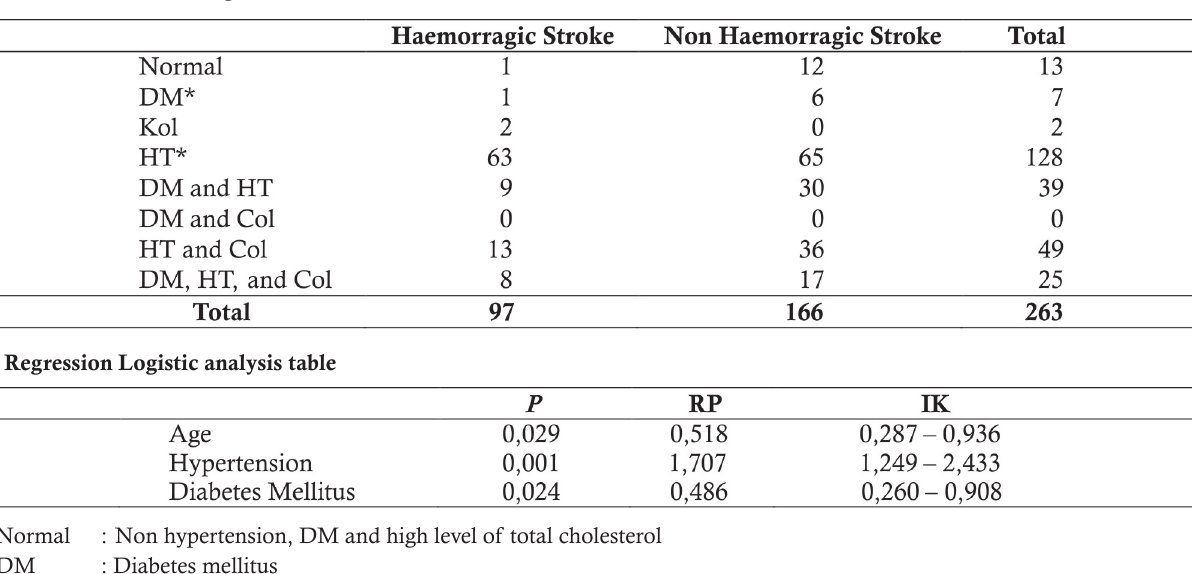
Saputri, et al. Table . Distribution of hypertension, Diabetes Mellitus, and High Cholesterol Level on Haemorragic Stroke and